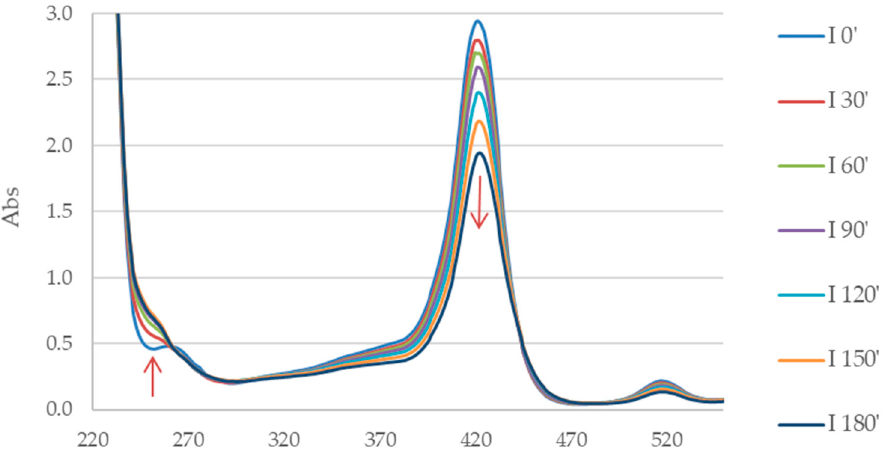
Figure 8. Photodegradation of porphyrin Tetra-Py+-Me in distilled water with solar light with an irradiance between 389 and 1206 W m − 2 and a Tetra-Py + -Me concentration of 25 µM. This test of photodegradation had an irradiation period of 180 min. Legend: irradiated samples (I) at different times of analysis.